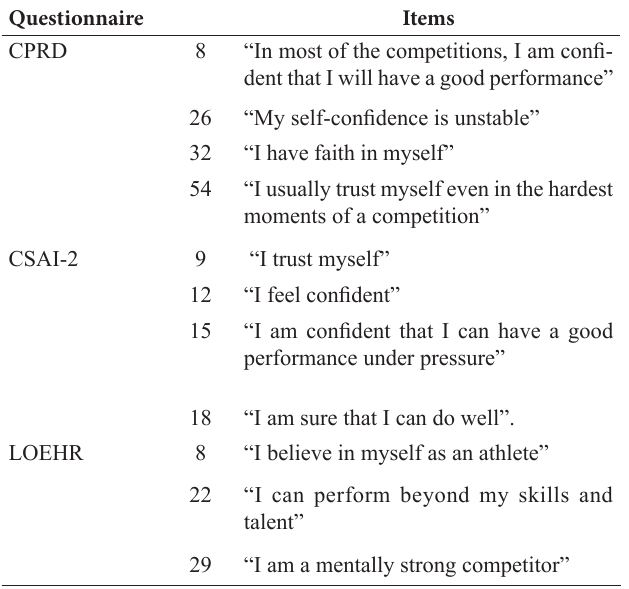
Table 1. CPRD, CSAI-2 and LOEHR selected items for the correla- tional study of self-confidence.